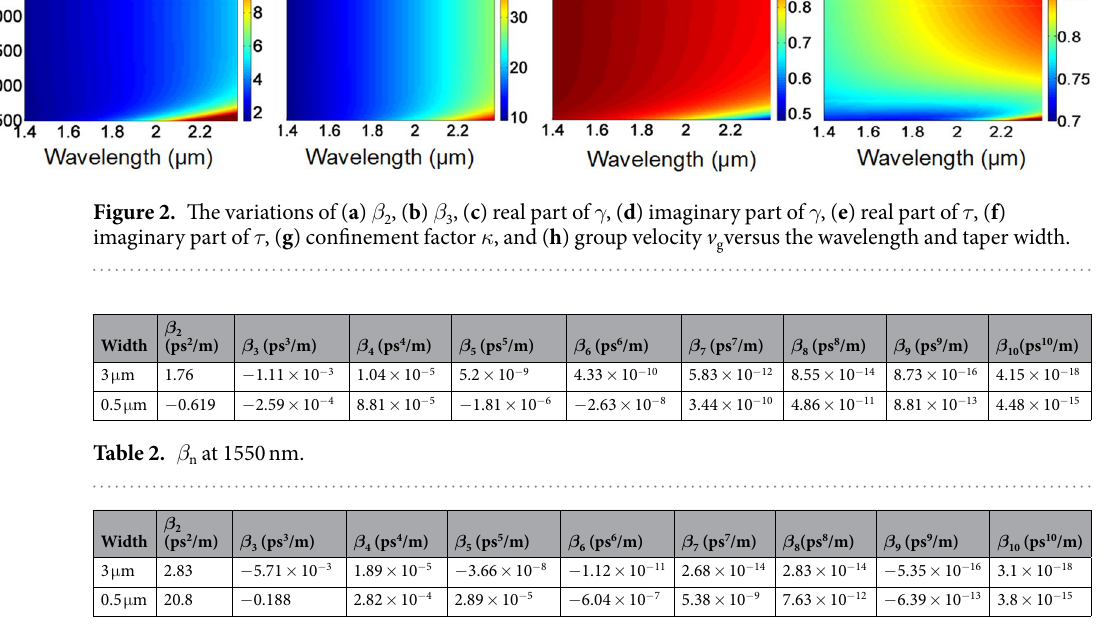
Table 3. β n at 2150